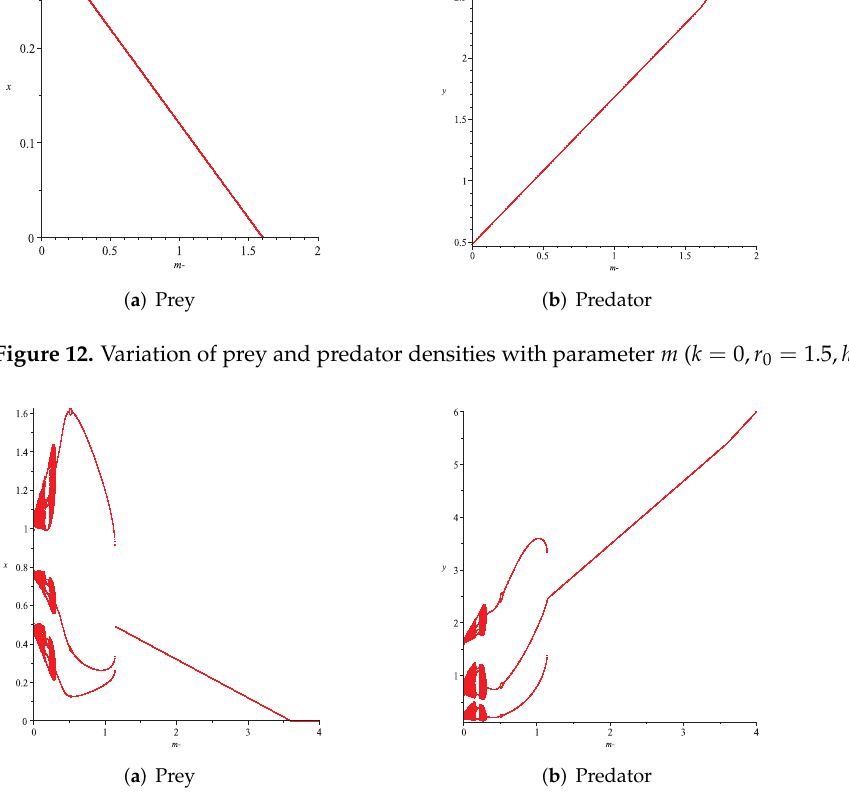
Figure 13. Variation of prey and predator densities with parameter m ( k = 0, r 0 = 3, h = 1.5).